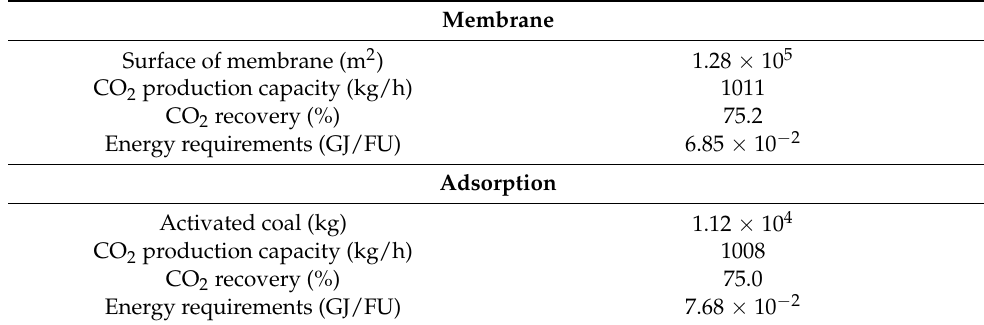
Table 7. Characteristics of membrane and adsorption processes with CO 2 at 40%.